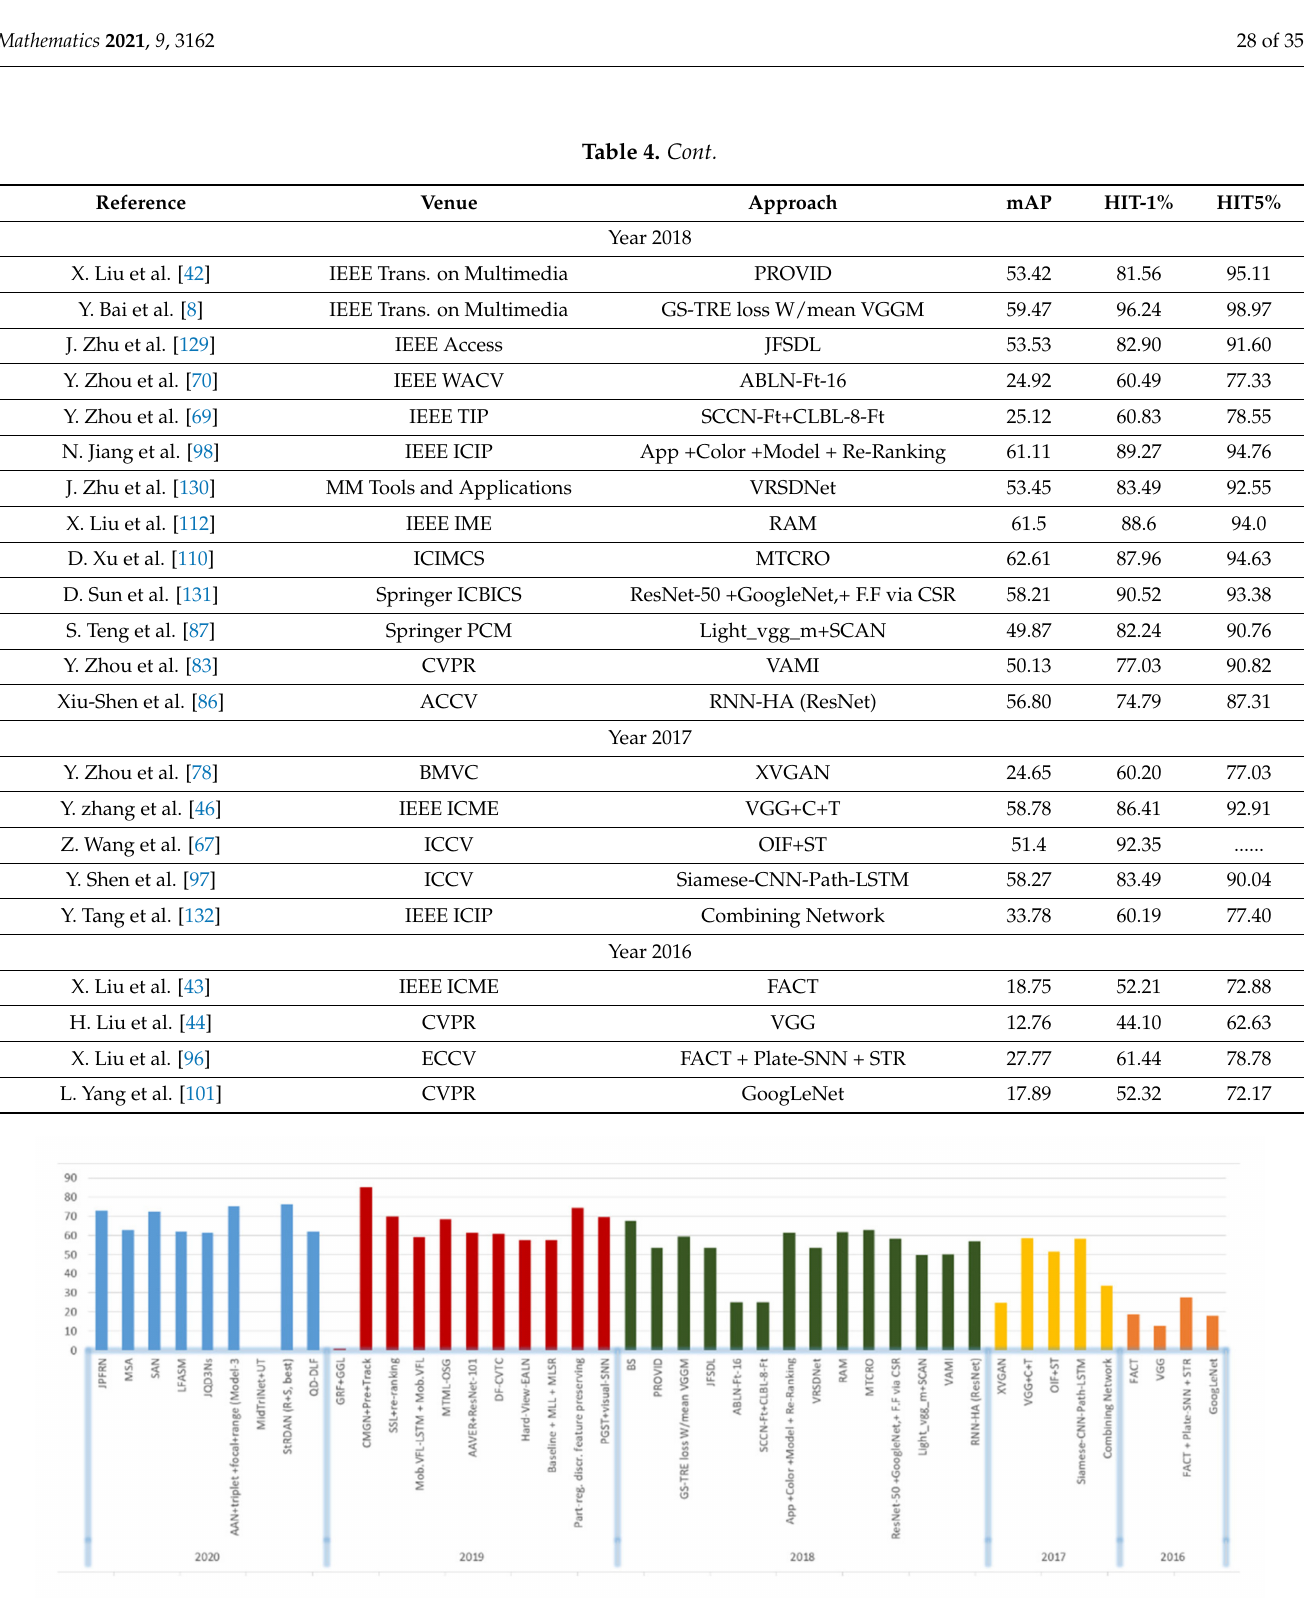
Figure 30. Demonstrates the performance comparison of different state of the art